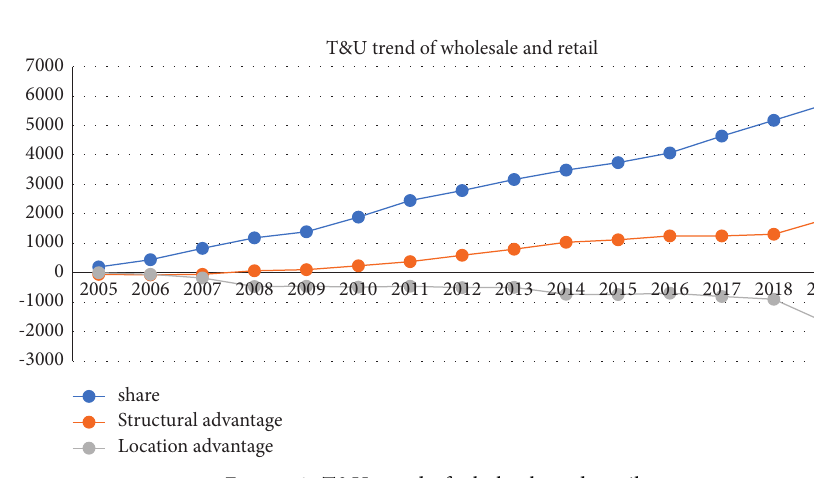
Figure 2: T&U trend of wholesale and retail.